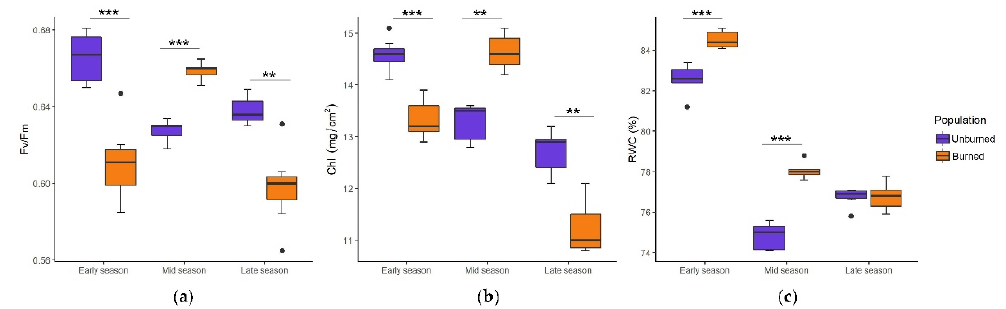
Figure 2. Seasonal dynamics of photosynthetic efficiency (Fv/Fm) ( a ), chlorophyll amount (Chl, mg/cm 2 ) ( b ), and relative leaf water content (RWC, %) ( c ) in C. reticulatus plants from unburned and burned sites. Boxplots represent the median value (bar) within the interquartile range, IQR (colored rectangle), the range between minimum and maximum value that are at the maximal distance 1.5×IQR from the first and third quartile, respectively (whiskers) and the outliers (black dots). Sta- tistically significant differences are indicated with asterisks, ** p < 0.01 *** p < 0.001.